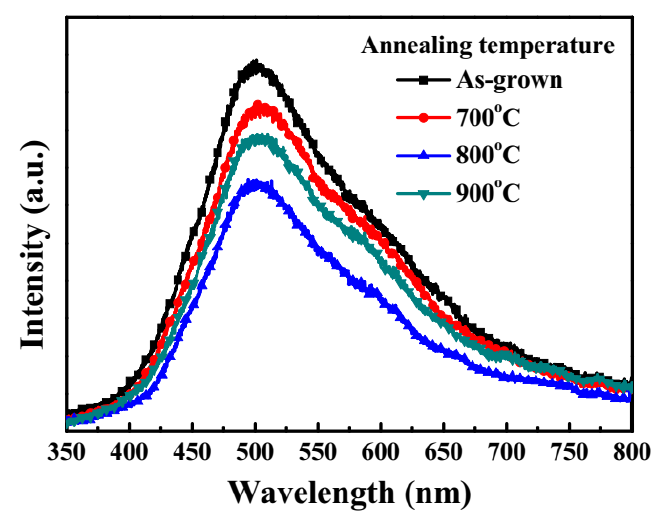
Figure 4. Room-temperature photoluminescence (PL) spectra of as-grown Ga 2 O 3 films and Ga 2 O 3 films annealed at various temperatures.